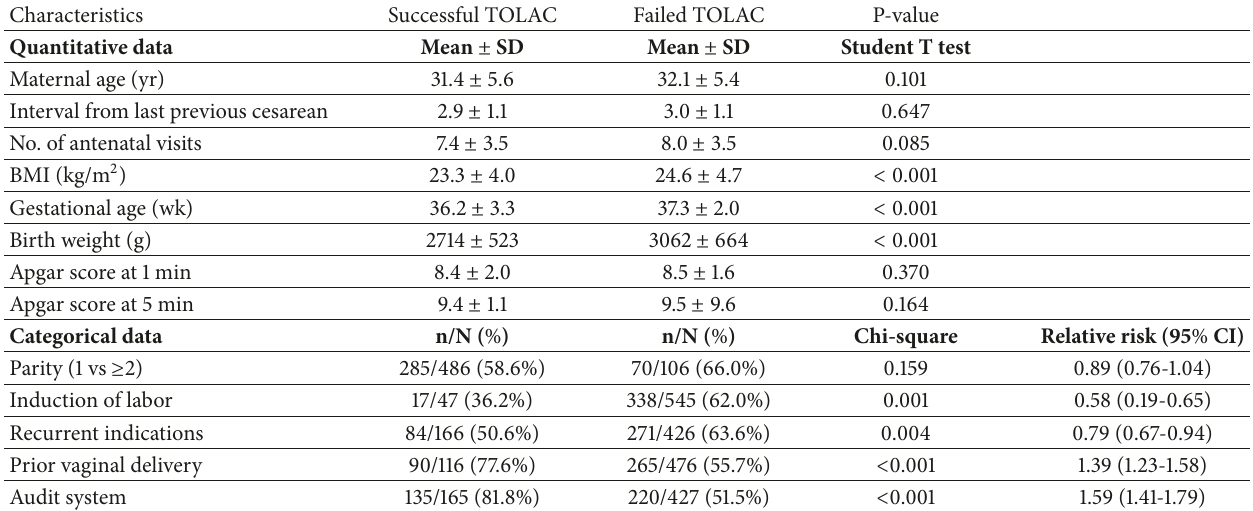
Table 1: Demographic and obstetric characteristics of the women with successful TOLAC and failed TOLAC.